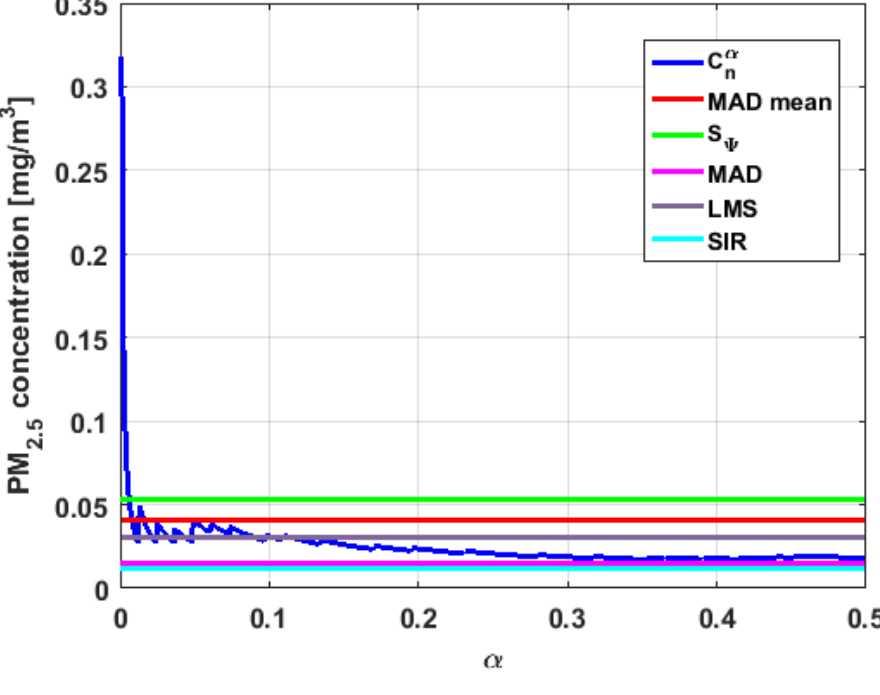
α n estimates of Y 3